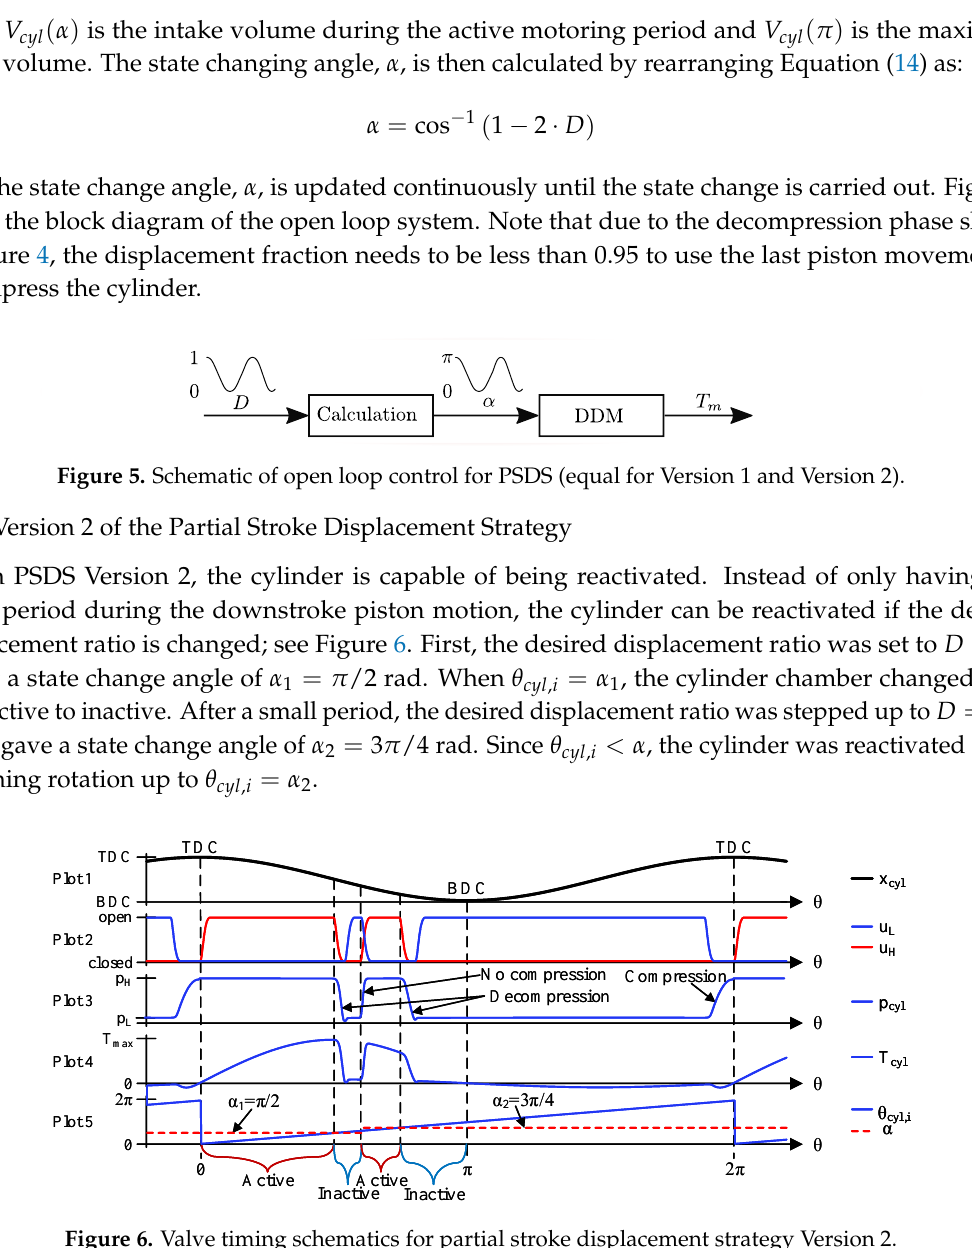
Figure 6. Valve timing schematics for partial stroke displacement strategy Version